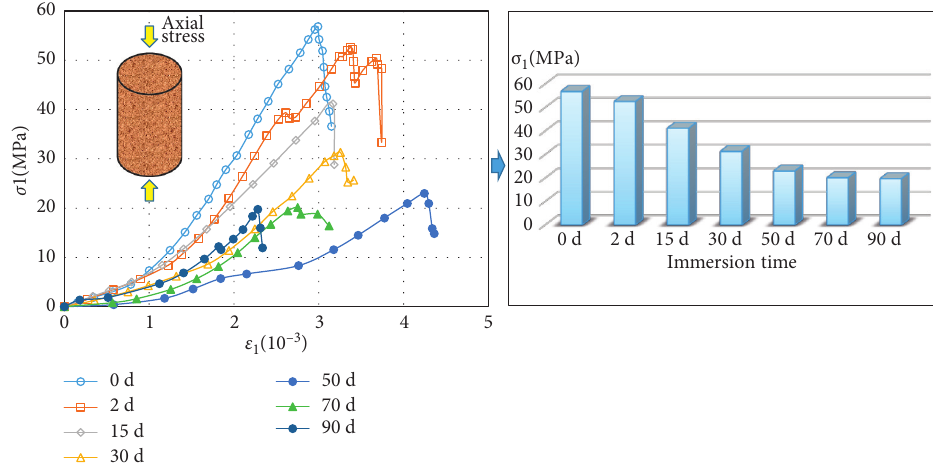
Figure 4: Stress-strain curve of shale with different immersion times under uniaxial compression.